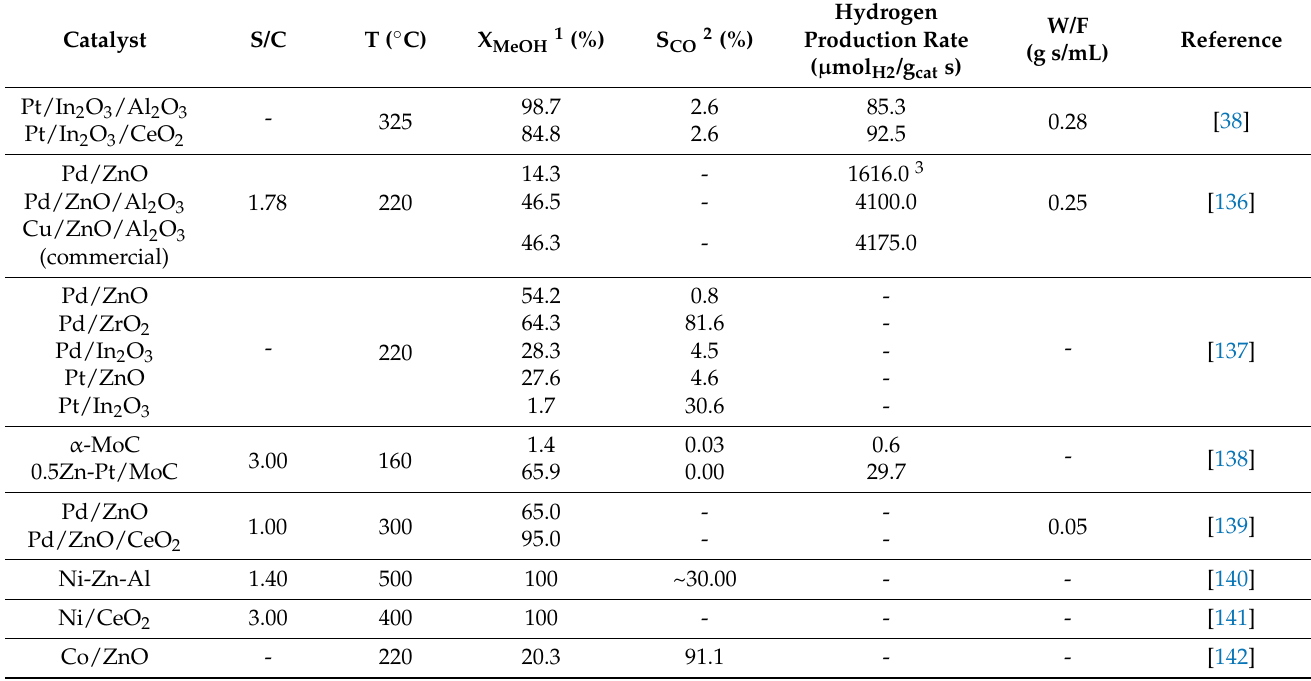
Table 4. Summary of various group 8–10 catalysts used in steam reforming of